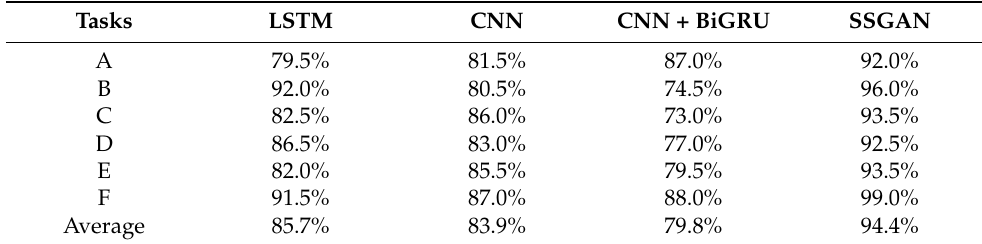
Table 3. Accuracy of different methods in six test